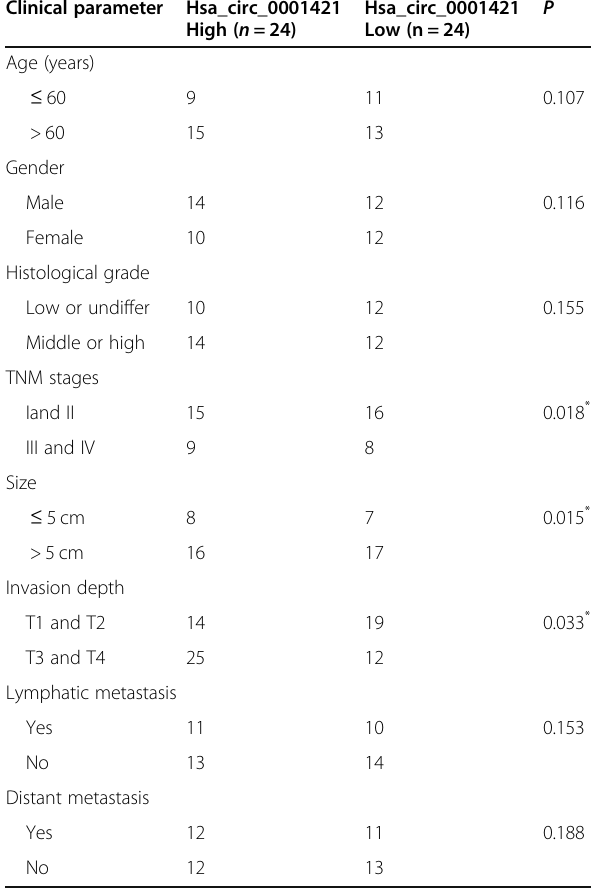
Table 1 Correlation between hsa_circ_0001421 expression and clinicopathological characteristics in lung